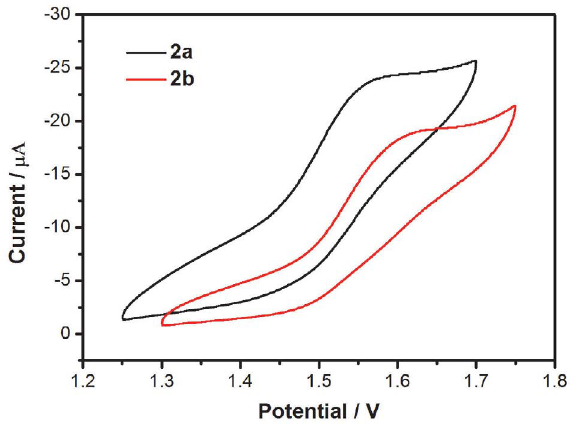
Fig. 5. Cyclic voltammograms for 2a–2b in CH 2 Cl 2 solution con- taining n-Bu 4 NClO 4 (0.1 M) at a sweep rate of 100